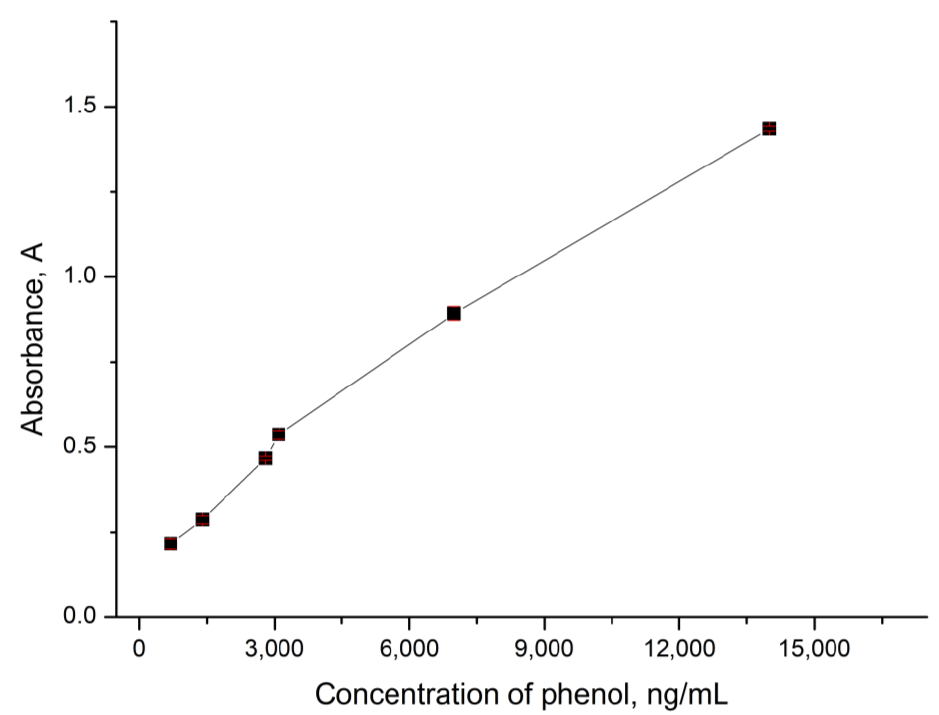
Figure 5. The optical density of the analyzed solution depending on the concentration of phenol.